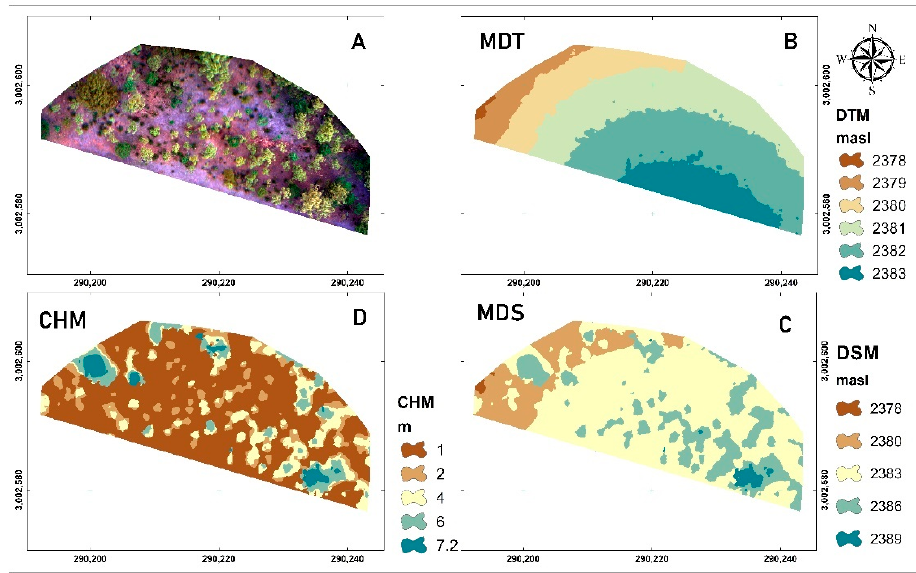
Figure 3. ( A ) = orthomosaic RGB, ( B ) = digital terrain model, ( C ) = digital surface model and ( D ) = canopy height model, derived from the UAV flight.